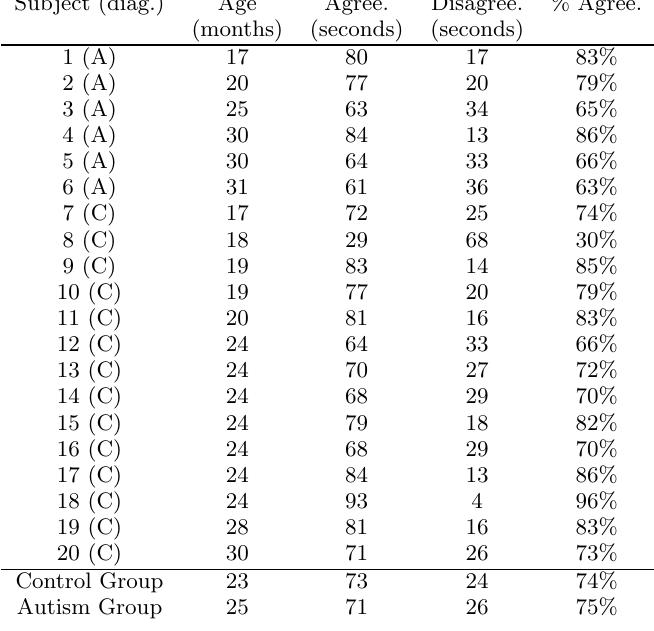
Table 1: Human coding compared to automated coding showing good overall agreement (75% across 20 subjects) and no apparent difference in mean agreement between the autism (A) and control (C)